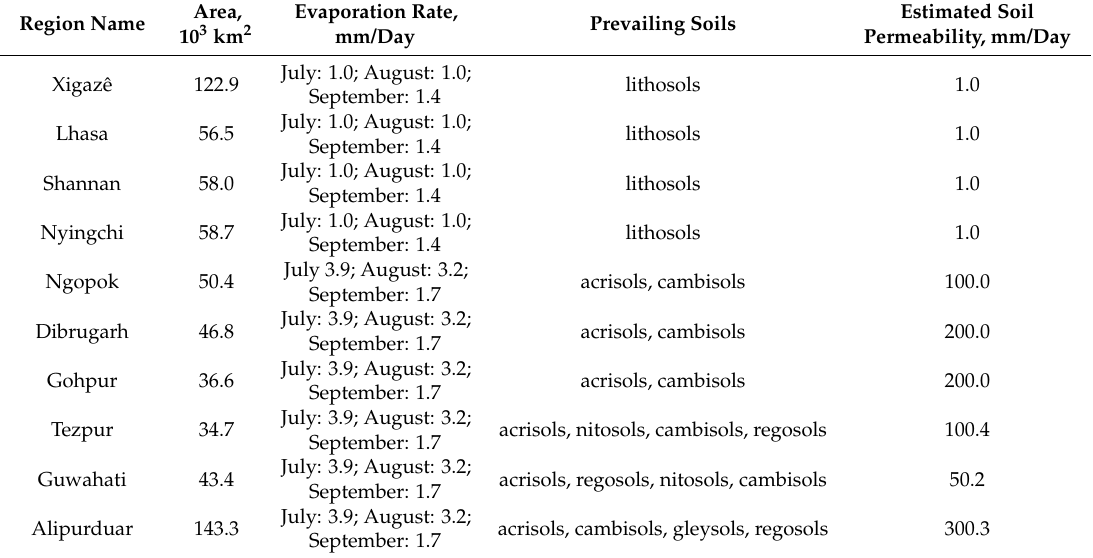
Table 4. The parameters of the Brahmaputra river basin